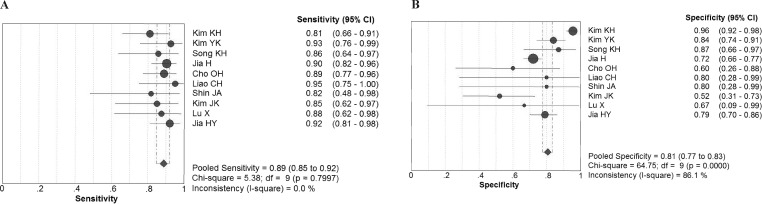
Forest plot evaluating the sensitivity and specificity of diagnostic performance of IGRA in tuberculous lymphadenitis.CI, confidence interval. (A) Sensivitity; (B) Specificity.